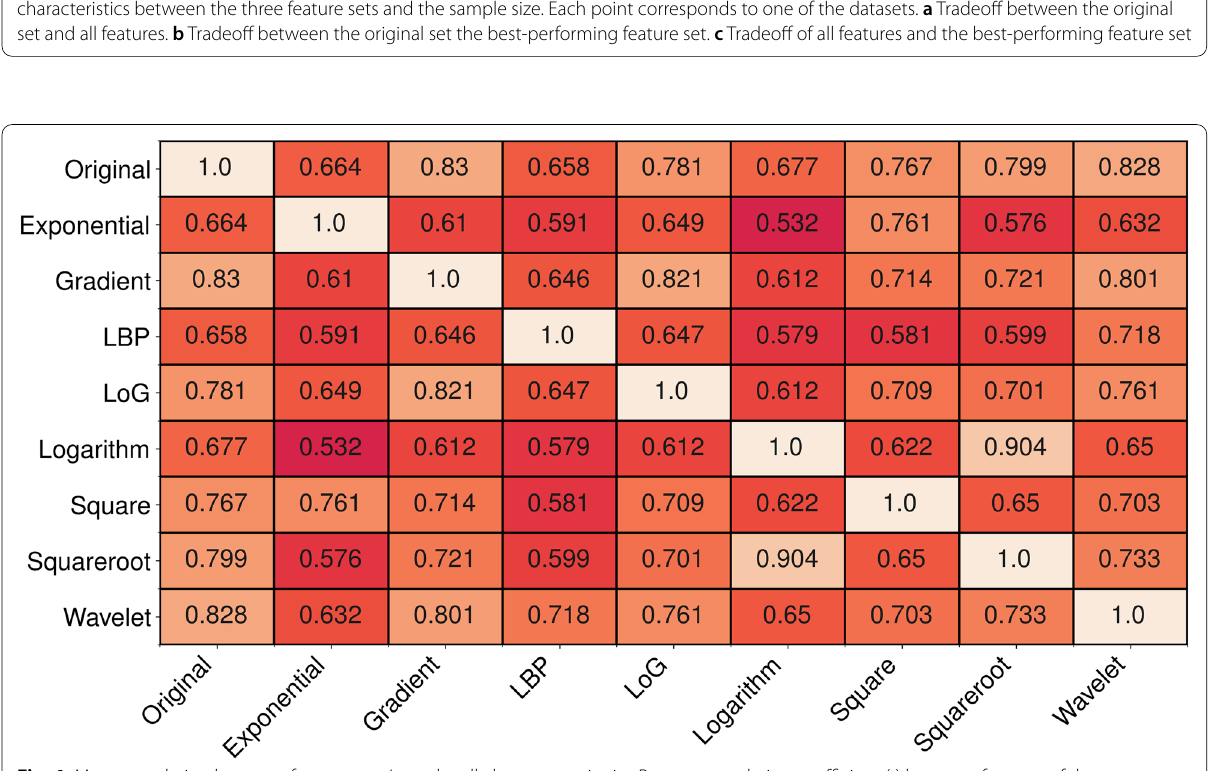
Correlation of features The mean correlation over all datasets ranged between r 0.49 and r 0.919 (Fig. 4). The local binary pattern and = = exponential filters showed the lowest correlation to the other feature sets (mean r 0.67 for both), while the cor- = relation of the original feature set was the highest (mean r 0.77). =